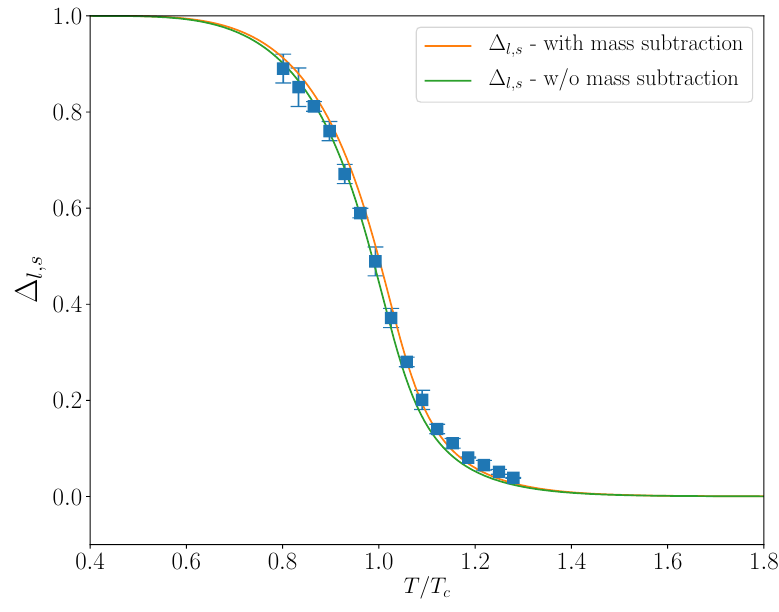
Figure 4. The relative-temperature T / T c dependence of the (normalized) subtracted quark condensate (19) from the lattice [83] (blue squares) and from our condensates. Slightly lower, green curve results from our unsubtracted condensates plugged in Equation (19), while the very slightly higher, red curve is from our already subtracted